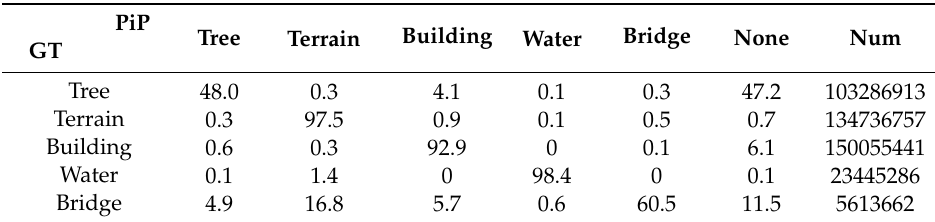
Table 1. Confusion matrix between the ground truth results and the point-in-polygon operation results for the training area. GT indicates the ground truth and PiP indicates the point-in-polygon operation. None, indicates unlabeled points and Num, indicates the number of the ground truth